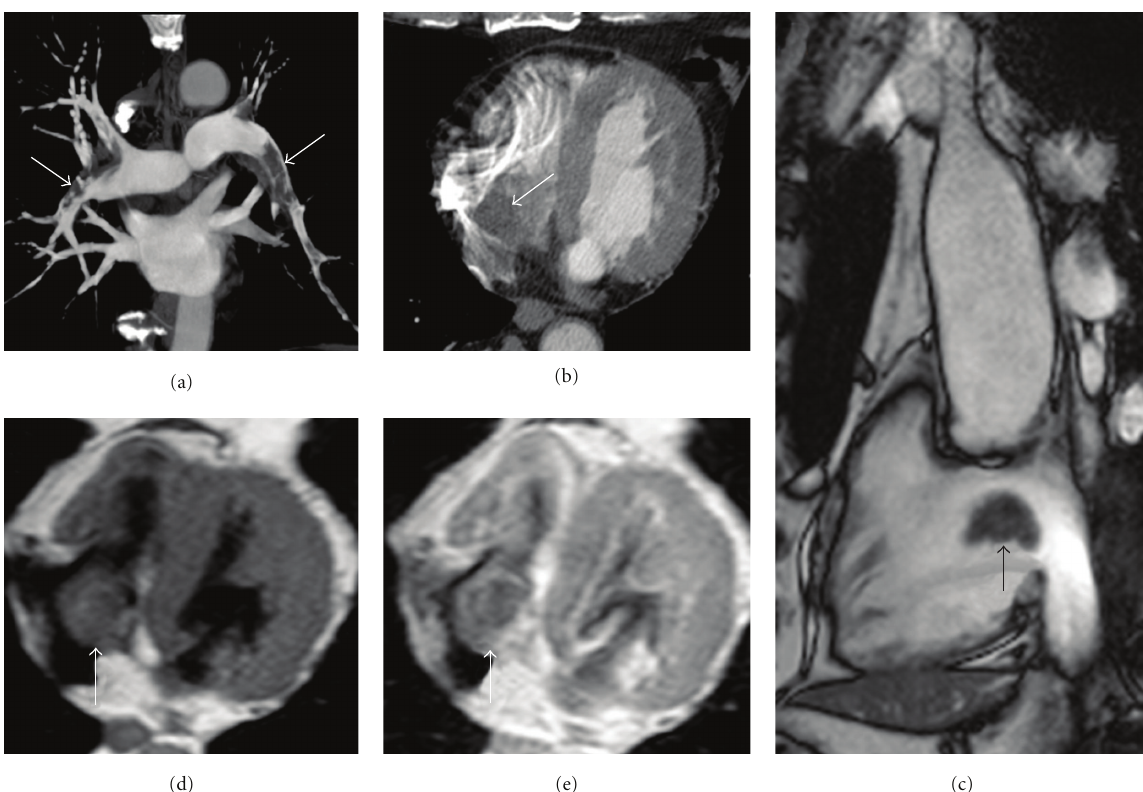
Figure 7: Thrombus. A coronal maximum intensity projection image from a contrast MDCT study demonstrates multiple pulmonary emboli ((a), white arrows). On the same study the possibility of a right atrial mass was raised ((b), white arrow), although it was uncertain whether this was real or simply an appearance due to incomplete mixing of opacified SVC blood with unopacified IVC blood. Cine CMR demonstrates that the mass is clearly real ((c), black arrow). Further characterization by CMR demonstrates that the mass is low signal on T1 weighted images ((d), white arrow) and remains low signal following gadolinium administration ((e), white arrow). The appearances and clinical presentation were entirely consistent with right atrial thrombus. The mass disappeared with subsequent